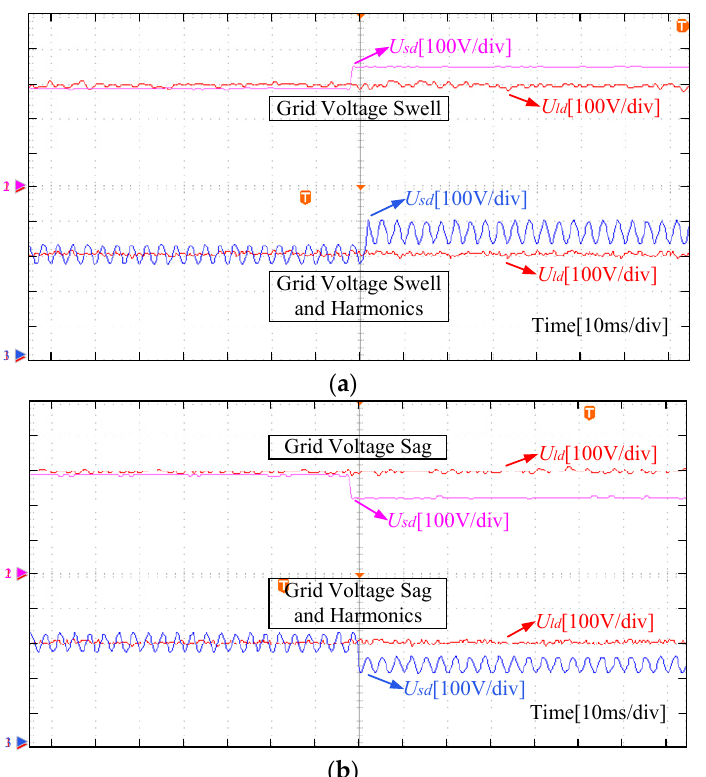
load voltage after compensation.